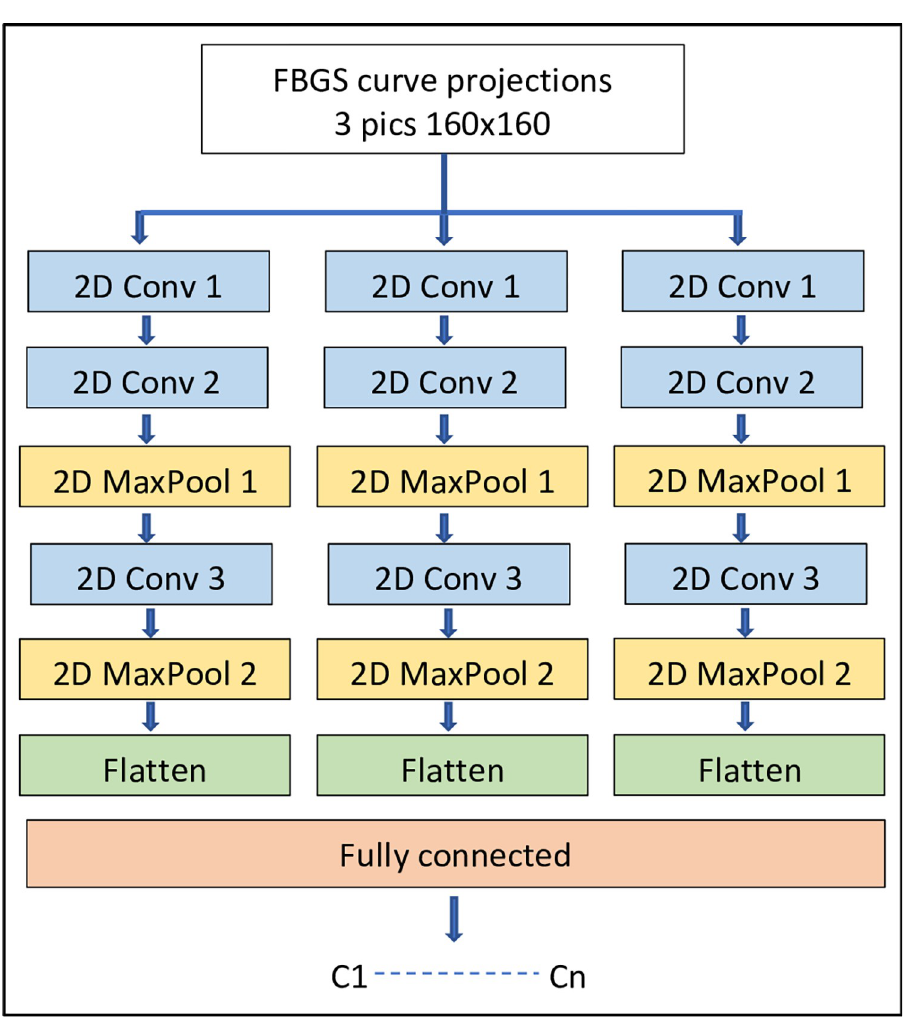
Fig 7. The MVCNN architecture for identification of the median lines of lung airways. Each median line is approximated with 500 AS curves and each AS curve is projected in three planes. For each projection, a CNN network is developed to identify its features. Individual CNN are fully connected into one output layer.